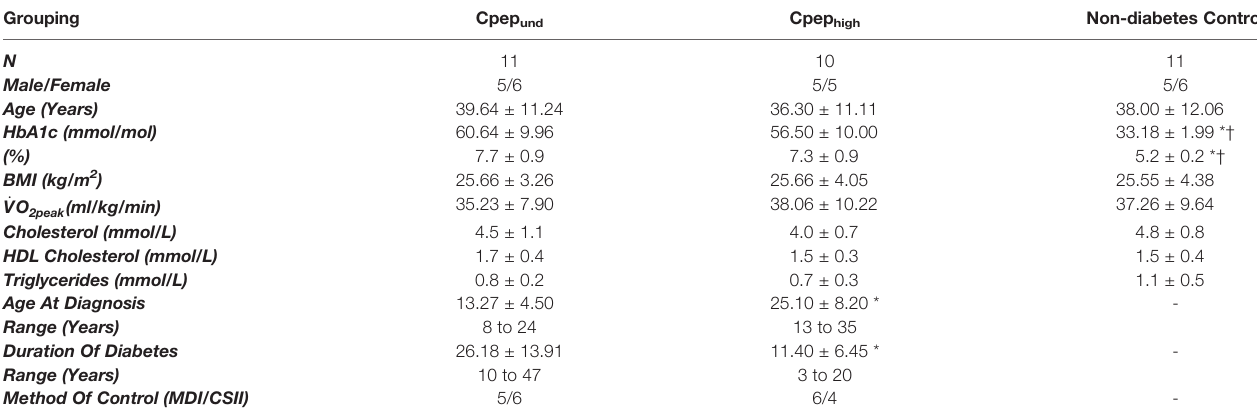
TABLE 1 | Participant demographic